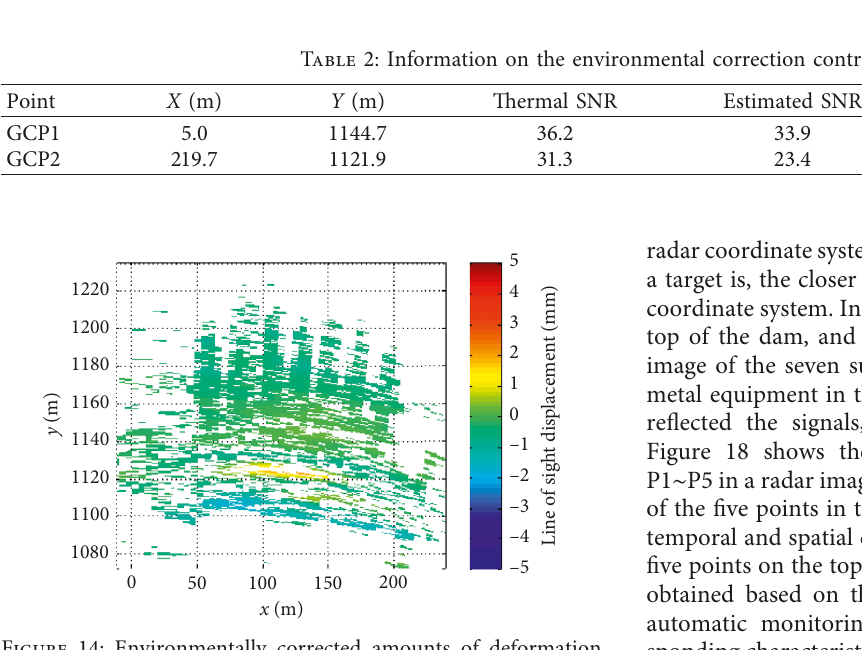
Figure 14: Environmentally corrected amounts of deformation (the shade of color represents the magnitude and direction of the displacement).